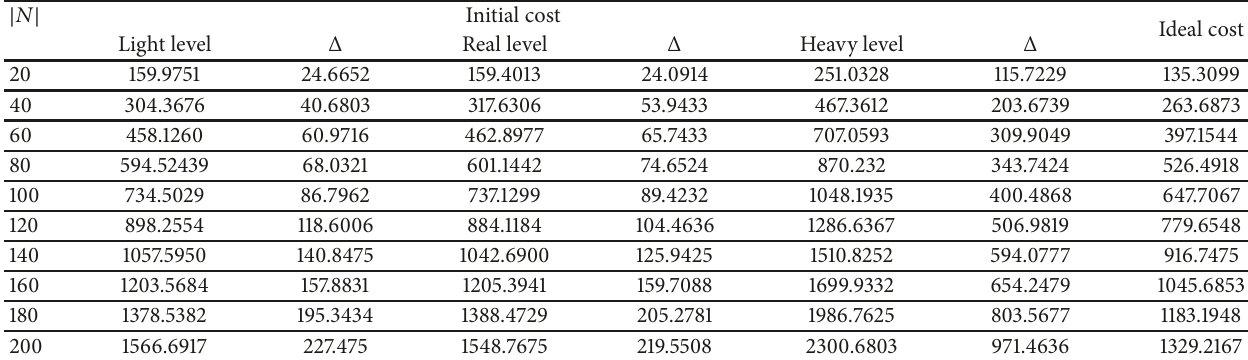
Table 5: Characterization of the numerical